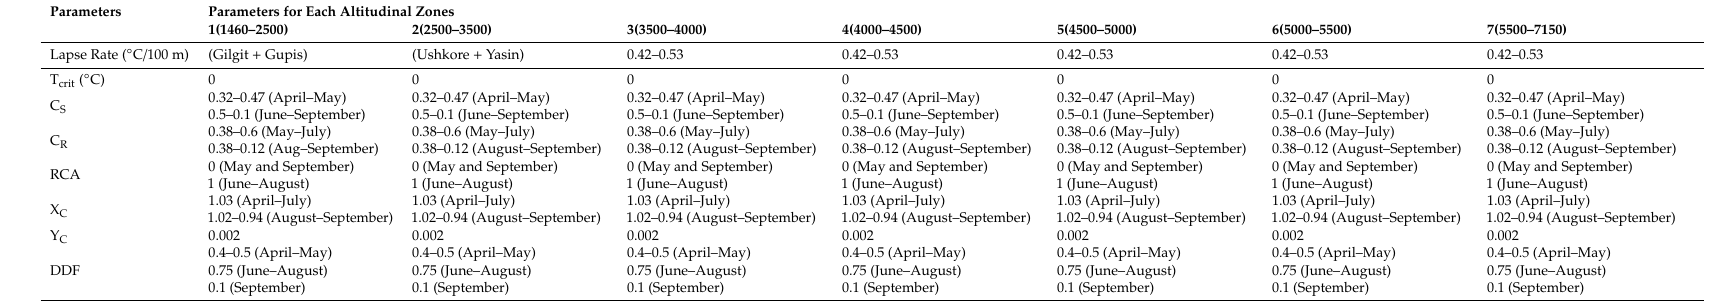
Table 3. Calibration parameter values for zone-wise SRM application to the Gilgit River